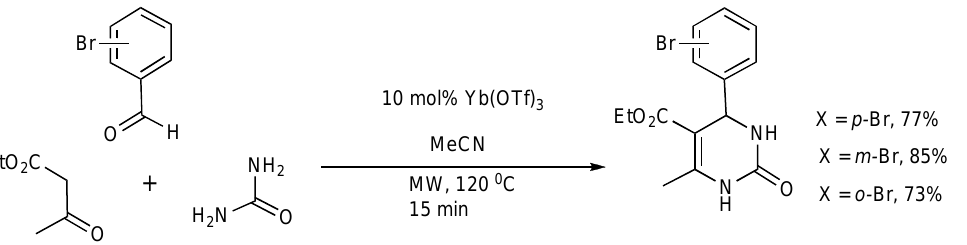
Scheme 2. Optimized Biginelli reaction conditions for bromophenyl-substituted DHPM